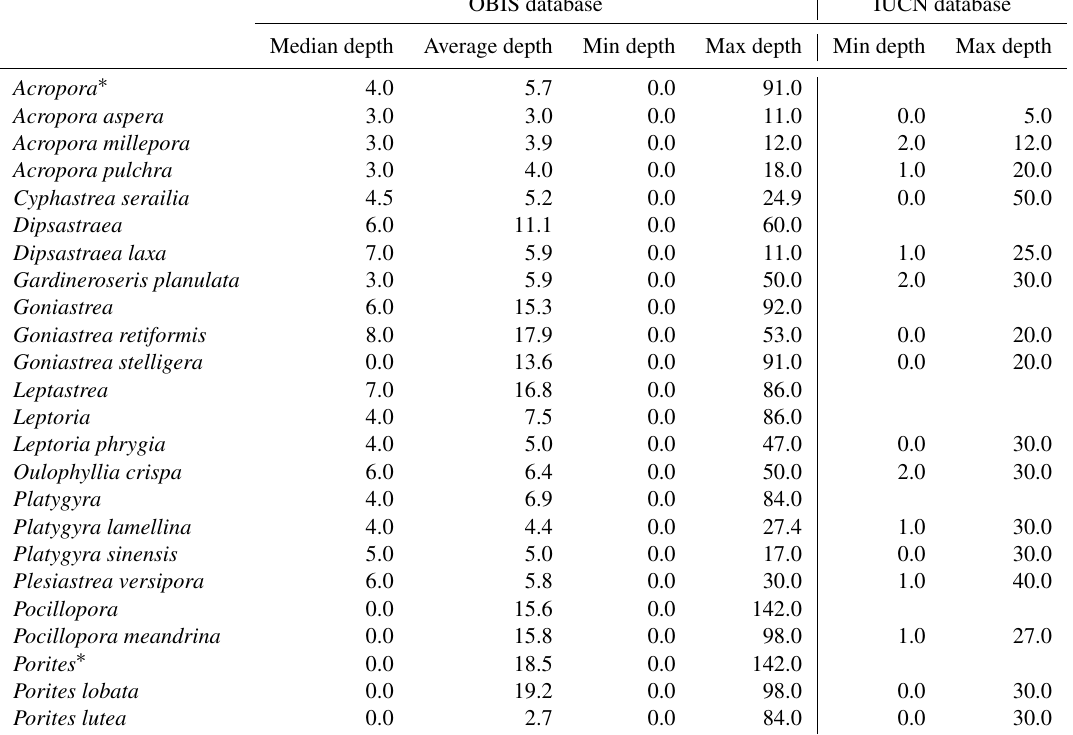
Table 2. Modern depth distribution (in metres below mean sea level – MSL) of corals identified in LIG records from the tropical Pacific islands. This table is based on two databases: OBIS (Ocean Biodiversity Information System; https://obis.org, last access: 22 April 2021) and IUCN (International Union for Conservation of Nature; https://www.iucnredlist.org, last access: 22 April 2021).